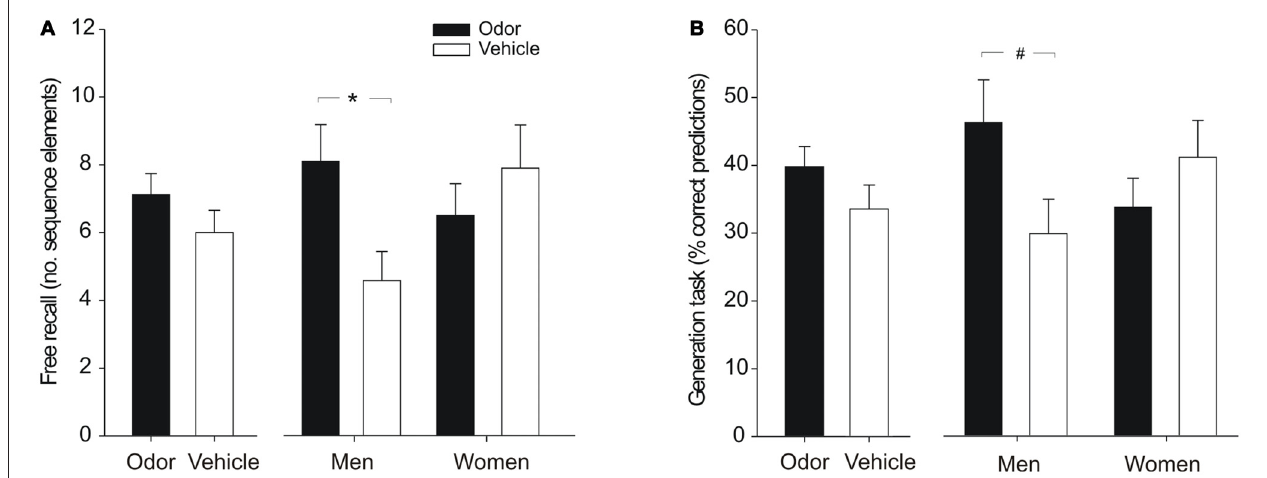
FIGURE 2 | Explicit sequence knowledge after odor cueing during sleep. (A) Free recall of the sequence did not differ significantly between the odor and vehicle groups in the whole sample (left panel). Analyzing male and female participants separately showed that odor cueing during SWS increased free recall of the sequence in men but not in women (right panel). Free recall is displayed as the number of correctly recalled sequence elements (range between 0–12). (B) Whereas performance on the generation task was not significantly increased by odor stimulation in the whole sample (left panel), odor reactivation tended to improve the ability to generate the sequence in men but not in women (right panel). Generation task performance refers to percent correct predictions of the next cue position upon presentation of two successive elements of the sequence. Mean ± SEM are shown. * p < 0.05, # p <